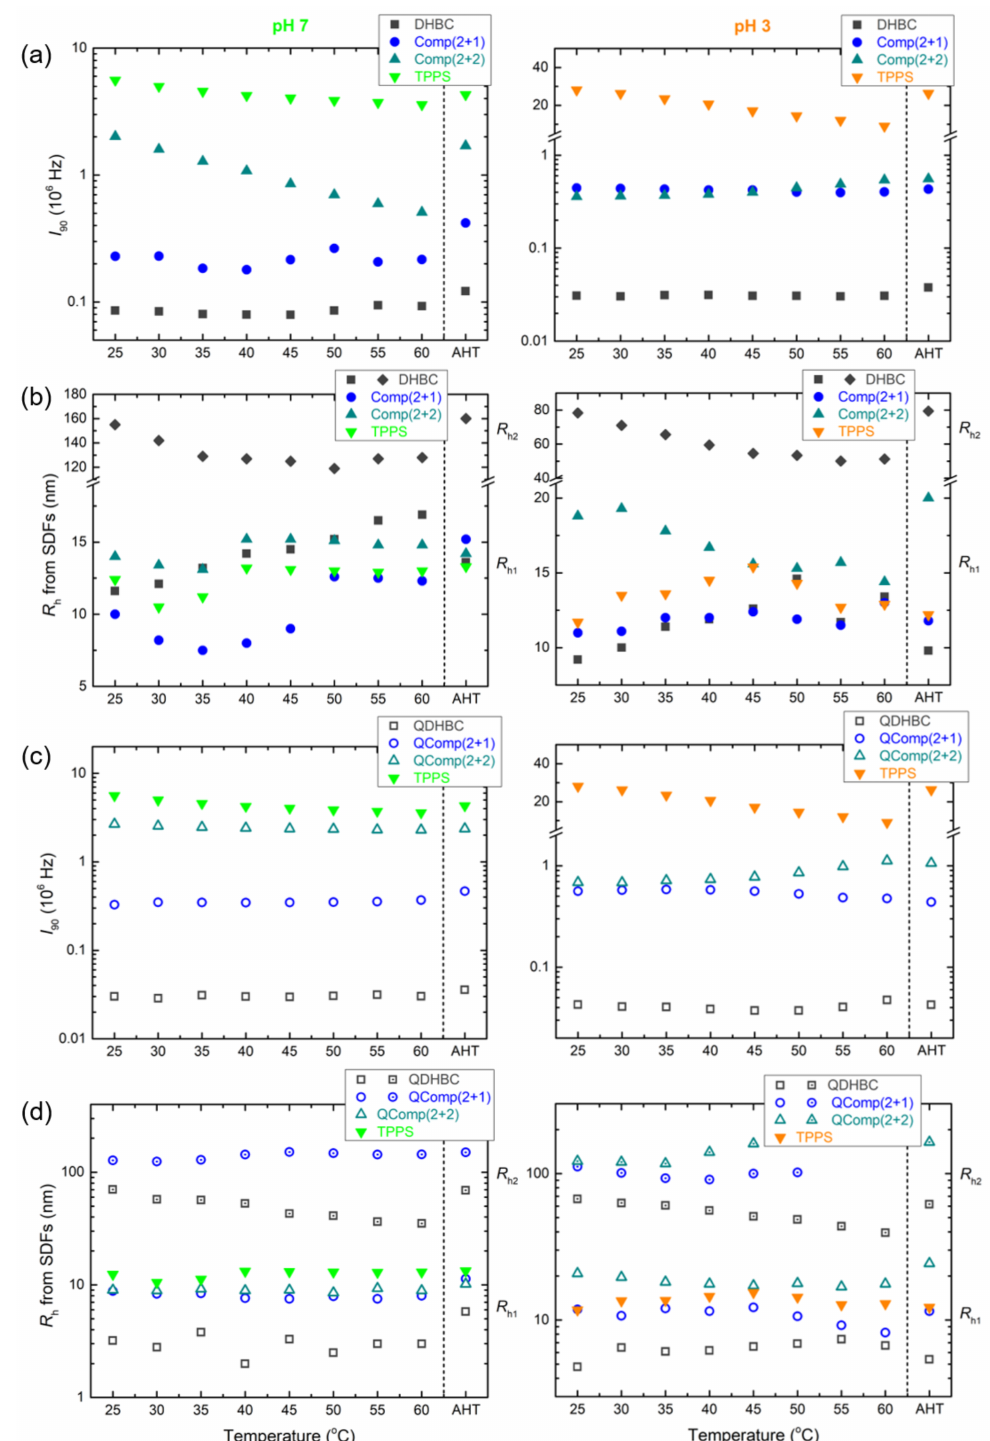
Figure 8. DLS results in regard to ( a , c ) the scattering intensity at 90 ◦ and ( b , d ) the hydrodynamic radius derived from the corresponding size distribution functions (SDFs) at 90 ◦ , for the complex solutions (Q)Comp (2 + 1) and (Q)Comp (2 + 2) of the (Q)DHBC/TPPS systems at pH 7 (left) and 3 (right) at different temperatures ranging from 25 to 60 °C (5 °C step), and cooled back at 25 °C after heat treatment (AHT). The corresponding values of neat (Q)DHBC and TPPS are also included for